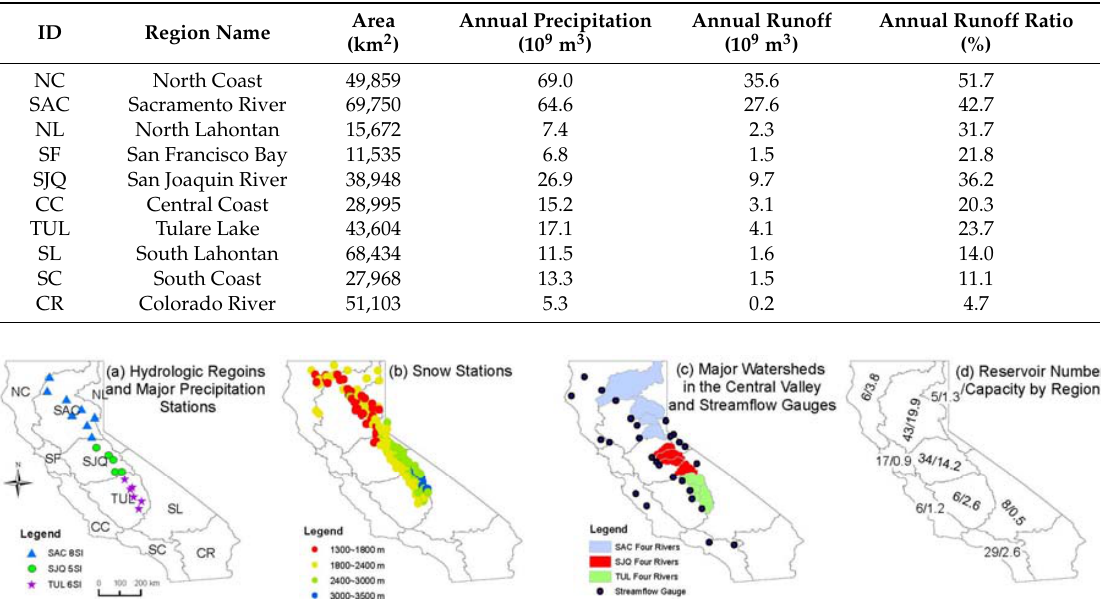
Figure 1. ( a ) Hydrologic regions and precipitation stations used in determining precipitation indices; ( b ) spatial distribution of 262 active snow stations within different elevation bands; ( c ) 12 major watersheds in the Central Valley; ( d ) number of reservoirs and the corresponding aggregated capacity (in 10 9 m 3 ) by hydrologic region.